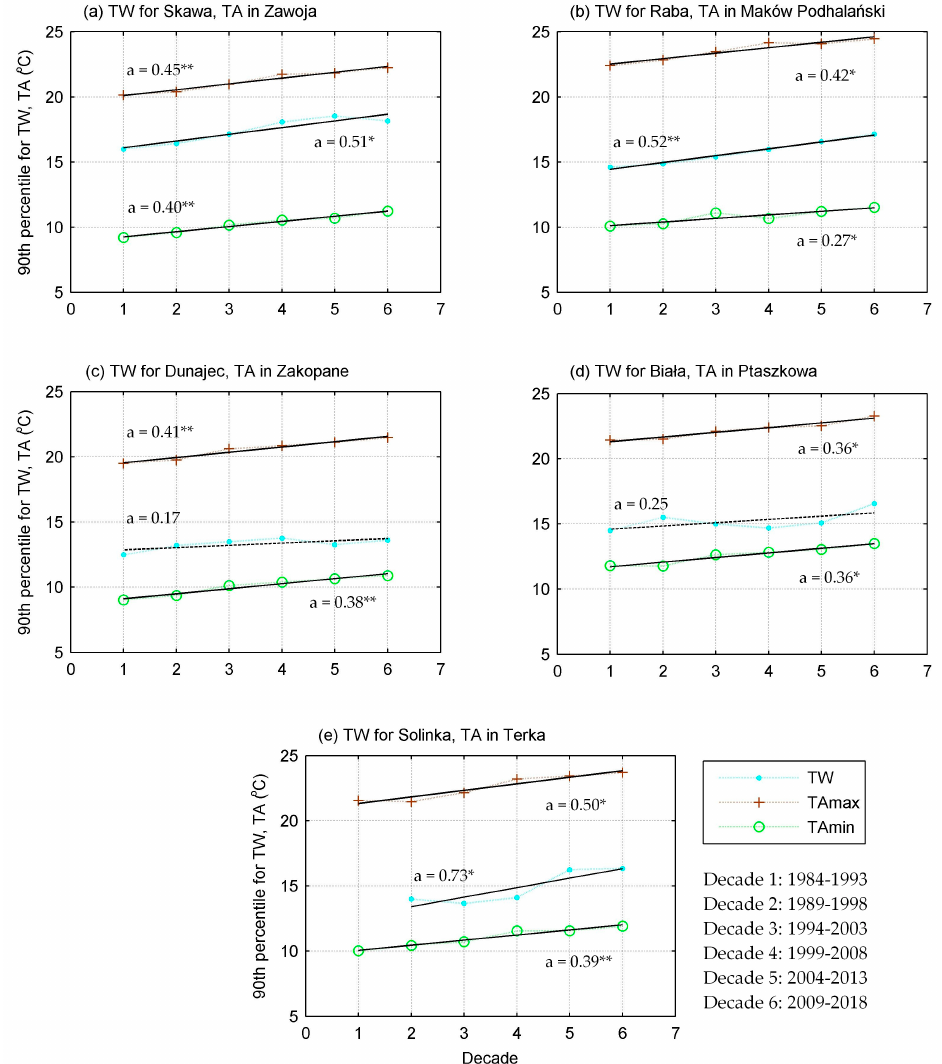
Figure 5. The 90th percentile for the monthly time series of water and air temperatures calculated in a moving window of 10 years with a 5-year shift. The comparisons were made for: ( a ) TW for the Skawa in Wadowice and TA in Zawoja; ( b ) TW for the Raba in Stró ż a and TA in Maków Podhala ń ski; ( c ) TW for the Dunajec in Nowy Targ-Kowaniec and TA in Zakopane; ( d ) TW for the Bia ł a in Grybów and TA in Ptaszkowa; ( e ) TW for the Solinka in Terka and TA in Terka. The intensity of the linear trend a (°C) is shown with its significance at p < 0.001 and p < 0.05 marked ** and *, respectively.